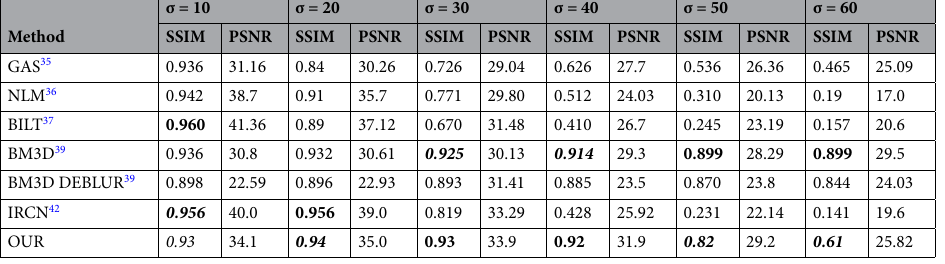
Table 1. Gaussian